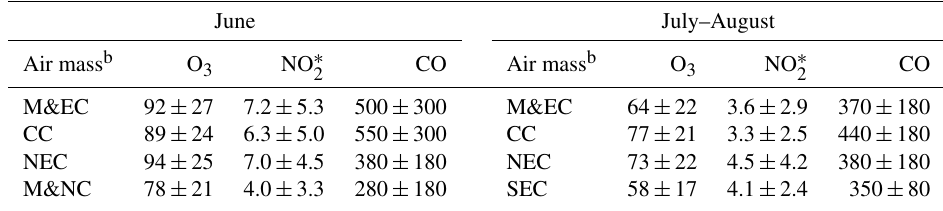
Figure 5. Climatological air mass transport pattern at Mt. Tai in (a) June and (b) July–August over 2003–2015. The maps are color-coded by the NO 2 column density retrieved from SCIAMACHY (2003–2011) and GOME-2(B) (2013–2015). The box (dashed line) refers to the domain for which the satellite retrievals were averaged. Five major air masses: (1) M&EC: Marine and East China, (2) NEC: Northeast China, (3) CC: Central China, (4) SEC: Southeast China, (5) M&NC: Mongolia and North China. Table 3. Statistics of O 3 , NO ∗ and CO in different air mass categories. a 2